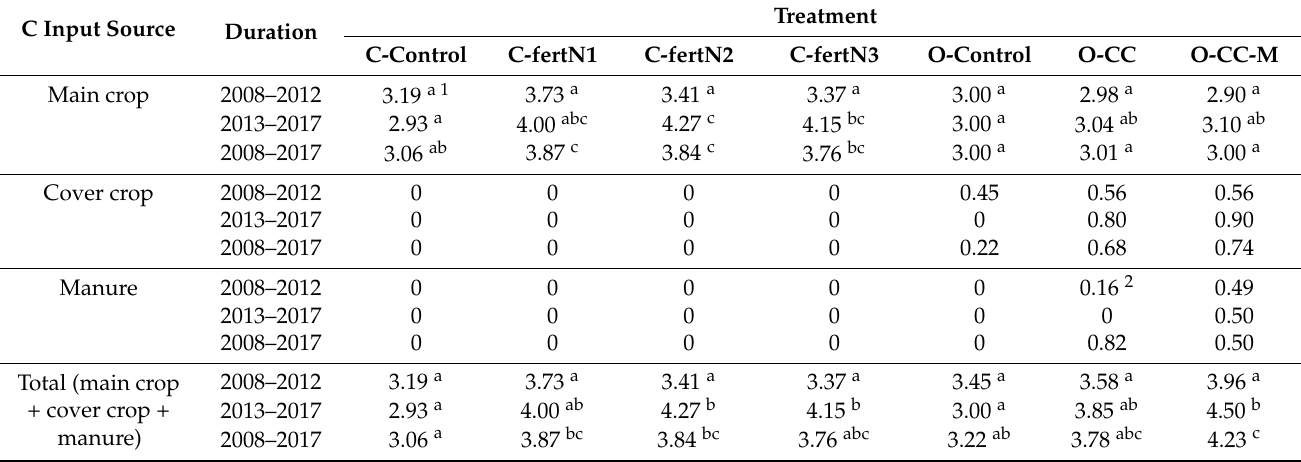
Table 4. Carbon (C) inputs (Mg C ha − 1 y − 1 ) during 2008–2018 according to treatment.